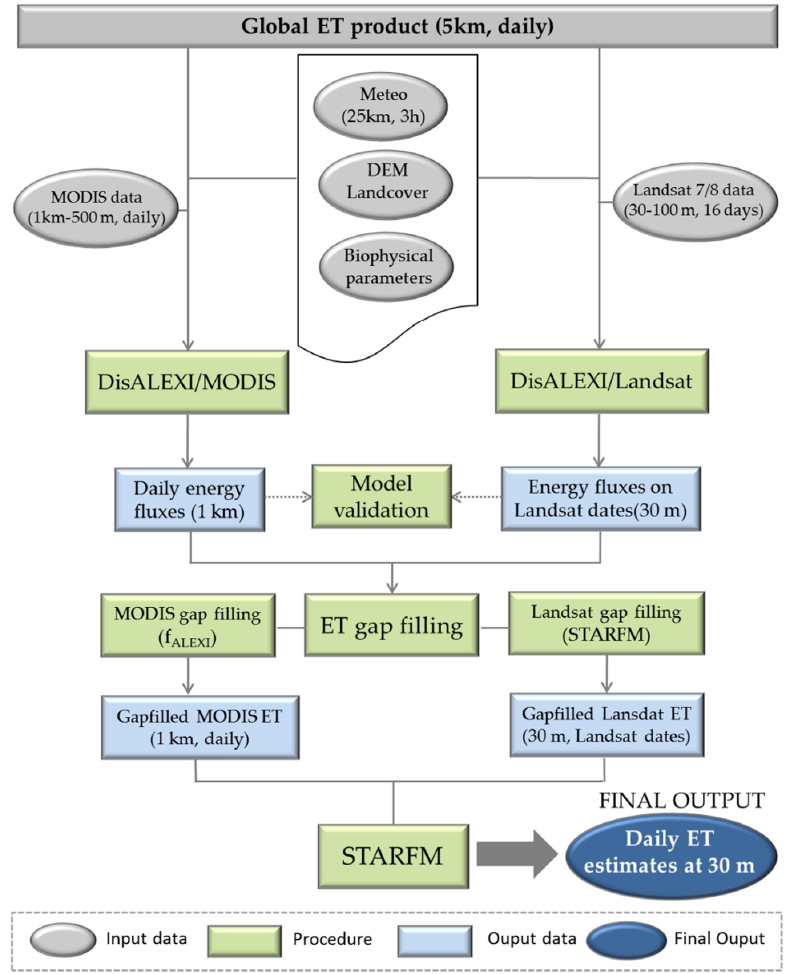
Figure 3. Flowchart of modeling framework applied to generate high resolution ET estimations.